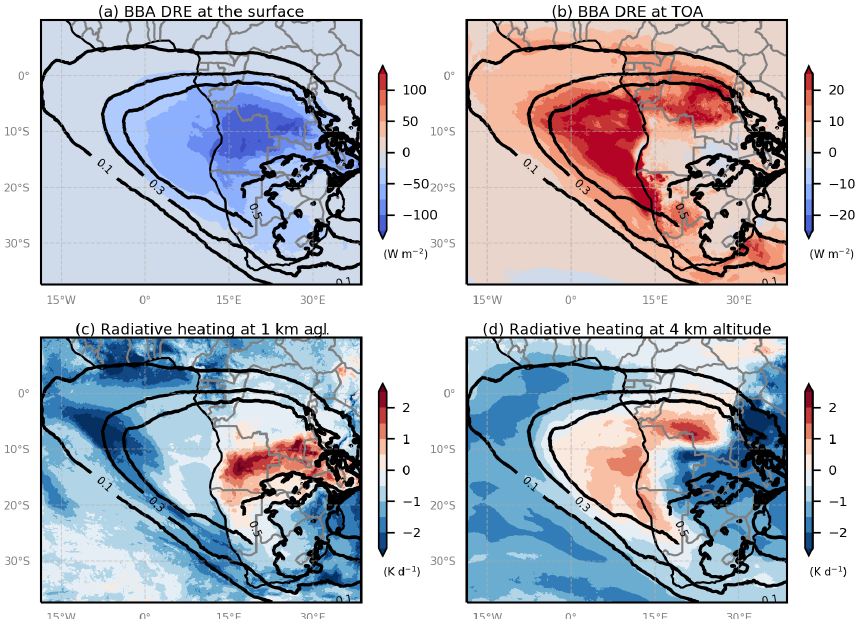
Figure 8. Results from the BBRAD ensemble mean: BBA DRE (Wm − 2 ) at (a) the surface and (b) top of the atmosphere (TOA), as well as radiative heating (Kd − 1 ) at (c) 1kma.g.l. and (d) 4km of altitude. Fields are averaged daily between 8 and 16 September